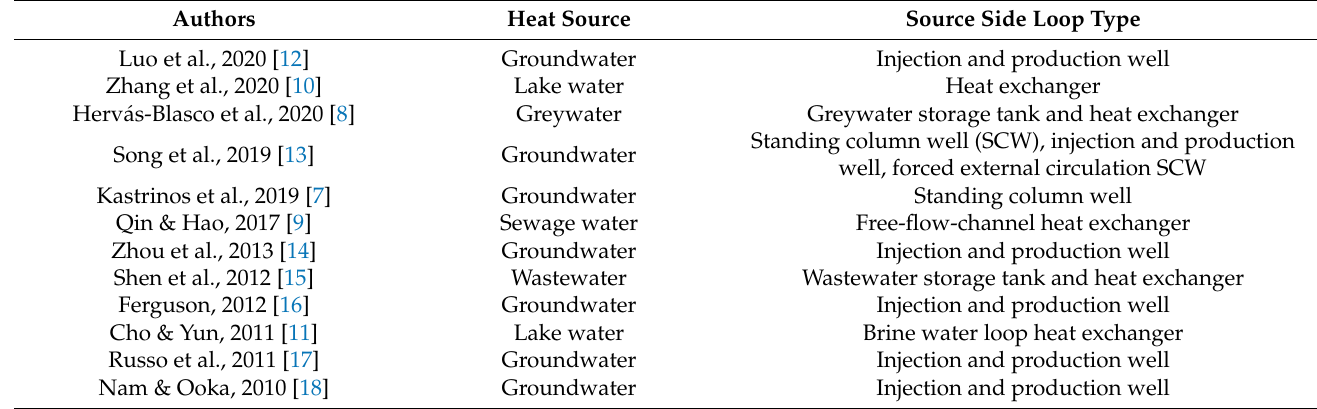
Table 1. Review of research on unused energy source heat pump